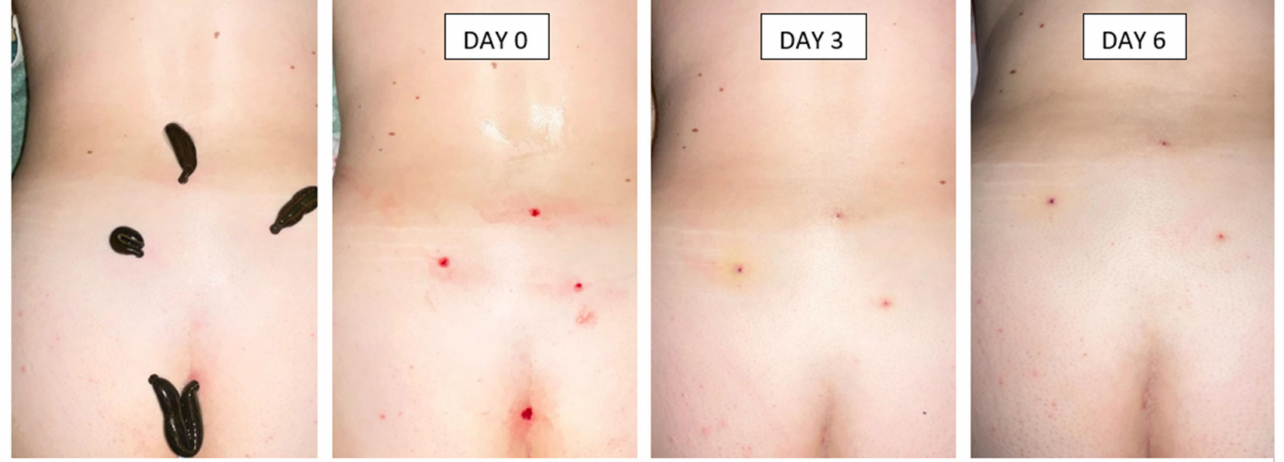
Figure 1. Photographs taken during the hirudotherapy treatment and photos of wounds in the healing process on day 3 and day 6 after applying the leeches (own documentation with the consent of the